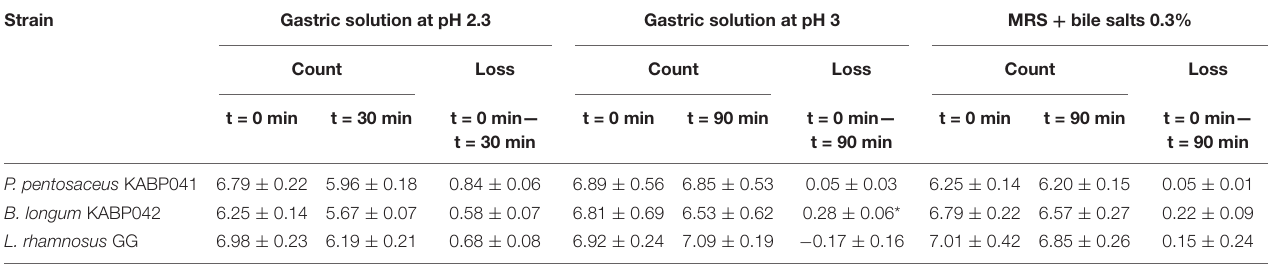
TABLE 2 | Tolerance to gastric stress and bile salts. Strain Gastric solution at pH 2.3 Gastric solution at pH